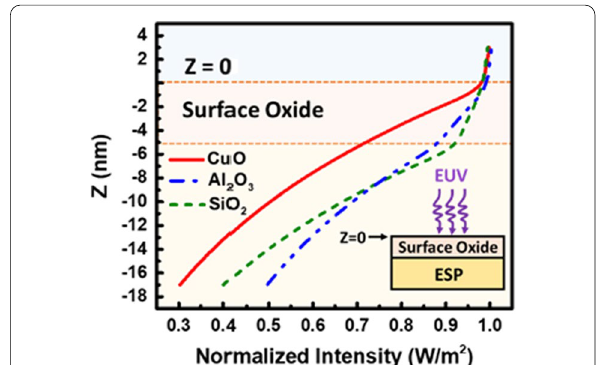
Fig. 5 The simulated EUV intensity profile along the Z ‑axis as it penetrates through the metal ESP covered by 5‑nm‑thick oxides